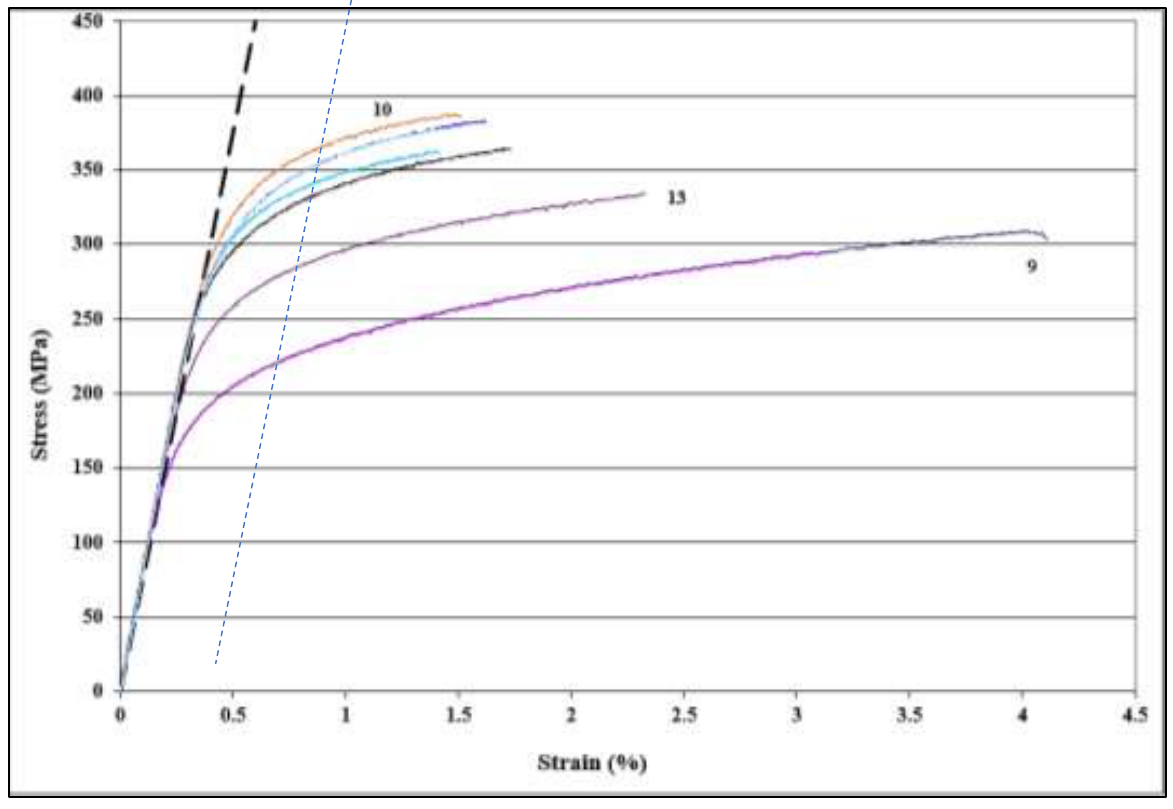
Figure 4. Stress-strain diagrams obtained from alloy B at room temperature following different heat treatment conditions. The broken blue line indicates 0.2% proof strain. The colors of the curves correspond to the heat treatment conditions as listed in Table 3 – of interest to note are the curves for treatments 10, 13 and 9